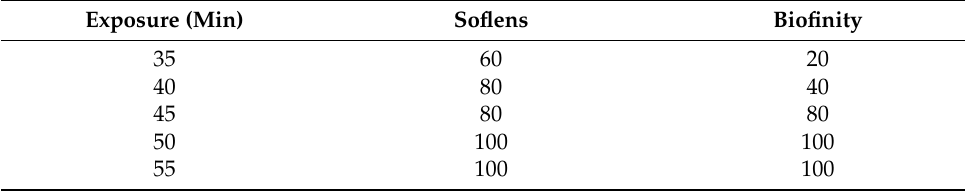
Table 2. Efficacy of negative discharge to inactivate Acanthamoeba cysts on surface of contact lenses. Inactivation of cysts contaminating surfaces on Soflens (Bausch&Lomb) and Biofinity (CooperVision) contact lenses is expressed as a